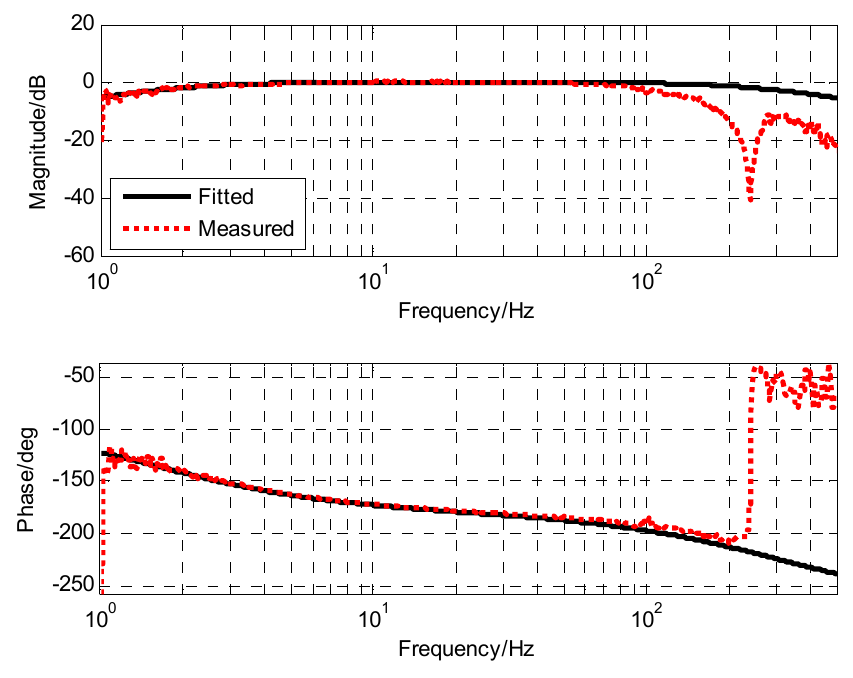
Figure 11. The open-loop Bode with MEMS gyroscope.